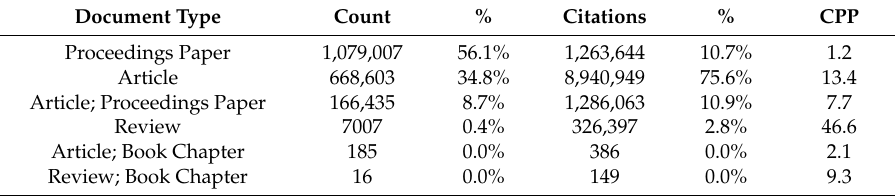
Table 1. Document types and their counts, citations, and citations per paper (CPP).